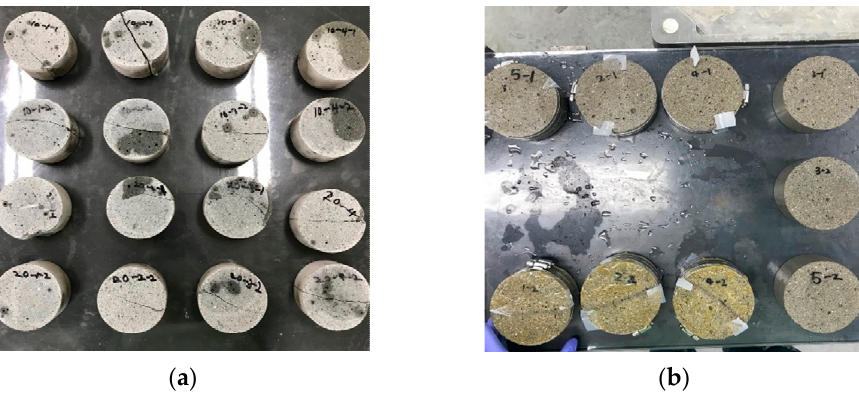
Figure 3. Uncoated and surface-coated specimens: ( a ) uncoated specimens and ( b ) surface-coated